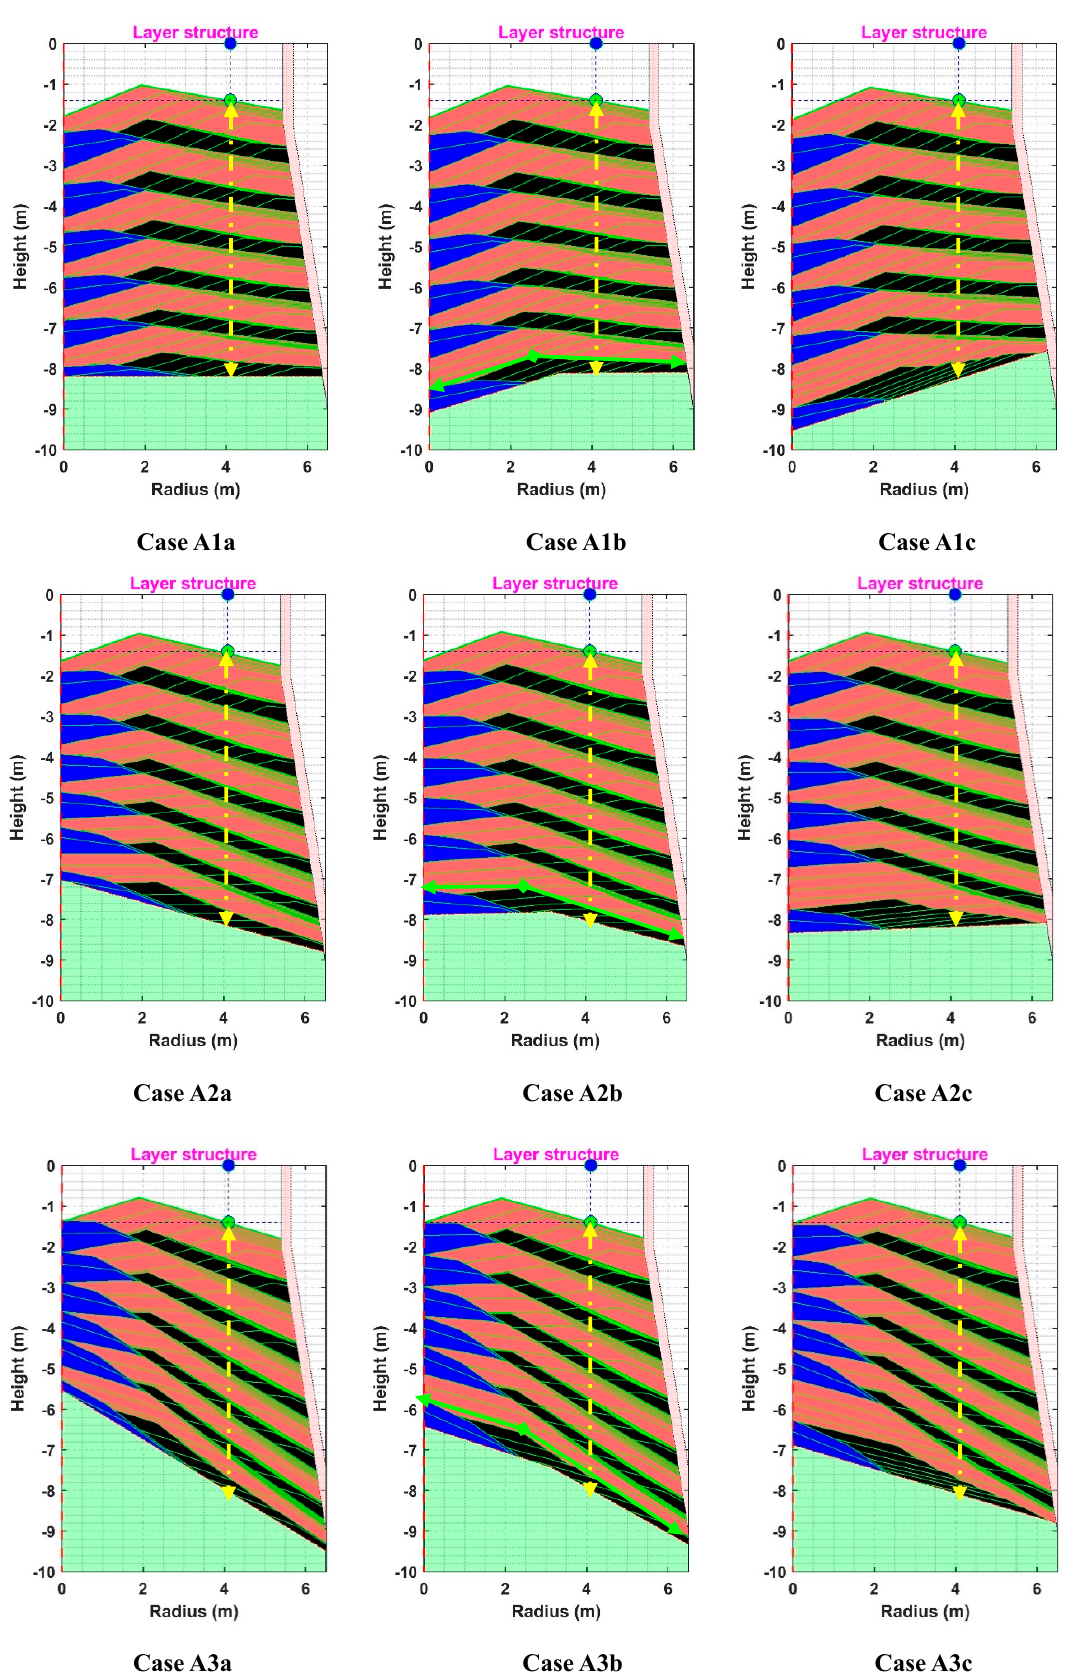
Figure 6. Effect of burden descent-rate distribution (rows) and initial burden surface (columns) on the